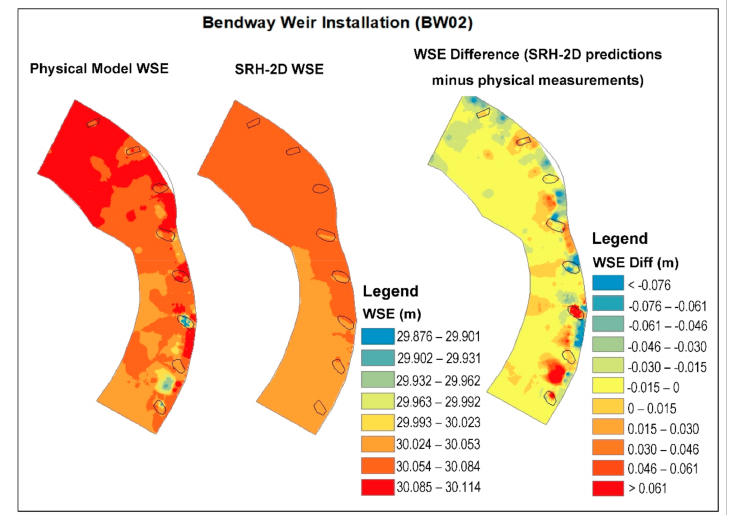
Figure 22. Bendway weir configuration BW02: comparison of physical model-measured and SRH- 2D-predicted WSE values.